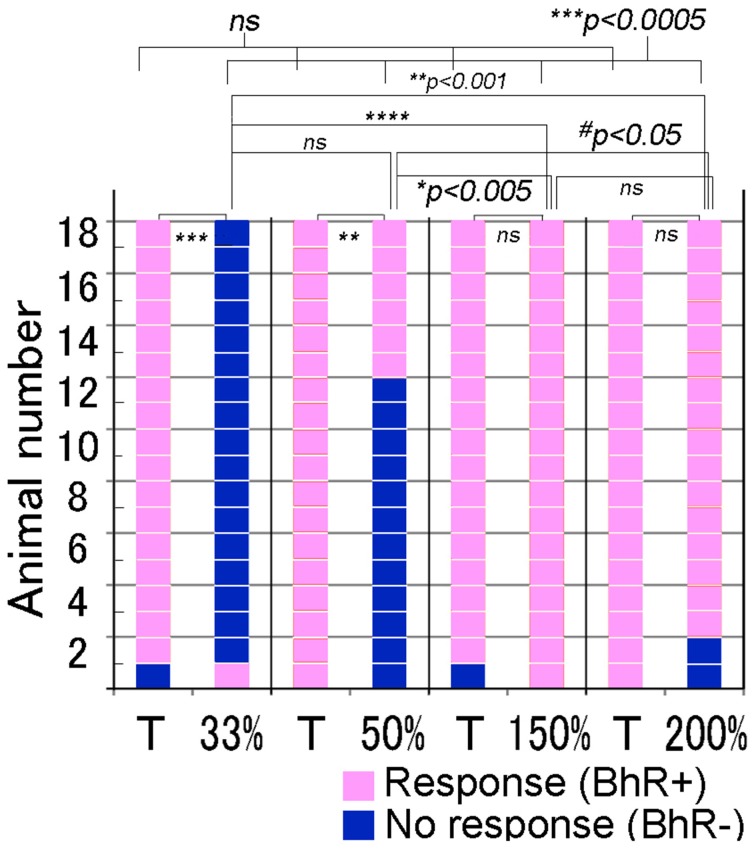
Performance of individual animals tested for discrimination of the test sounds modified in tempo or intersegment interval (ISI). To make the tempo test sounds (indicated in %-ISI), the ISI of the target (T) sound (i.e., CS) is shortened or elongated to the duration indicated in %. Target (T) sound is also played as the positive control together with the test sound in the same test trials. Pink indicates the positive response, while dark blue indicates the negative, so discriminative, response. #p < 0.05; *p < 0.005; **p < 0.001; ***p < 0.0005, ****p < 0.0001, and ns: p > 0.05.